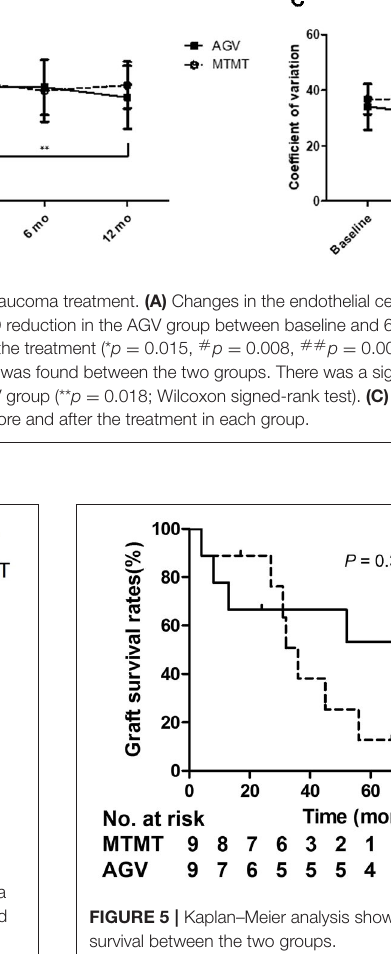
TABLE 4 | Superficial punctate epithelial keratopathy of the corneal grafts in the MTMT and AGV groups. Superficial punctate epithelial keratopathy (No. of